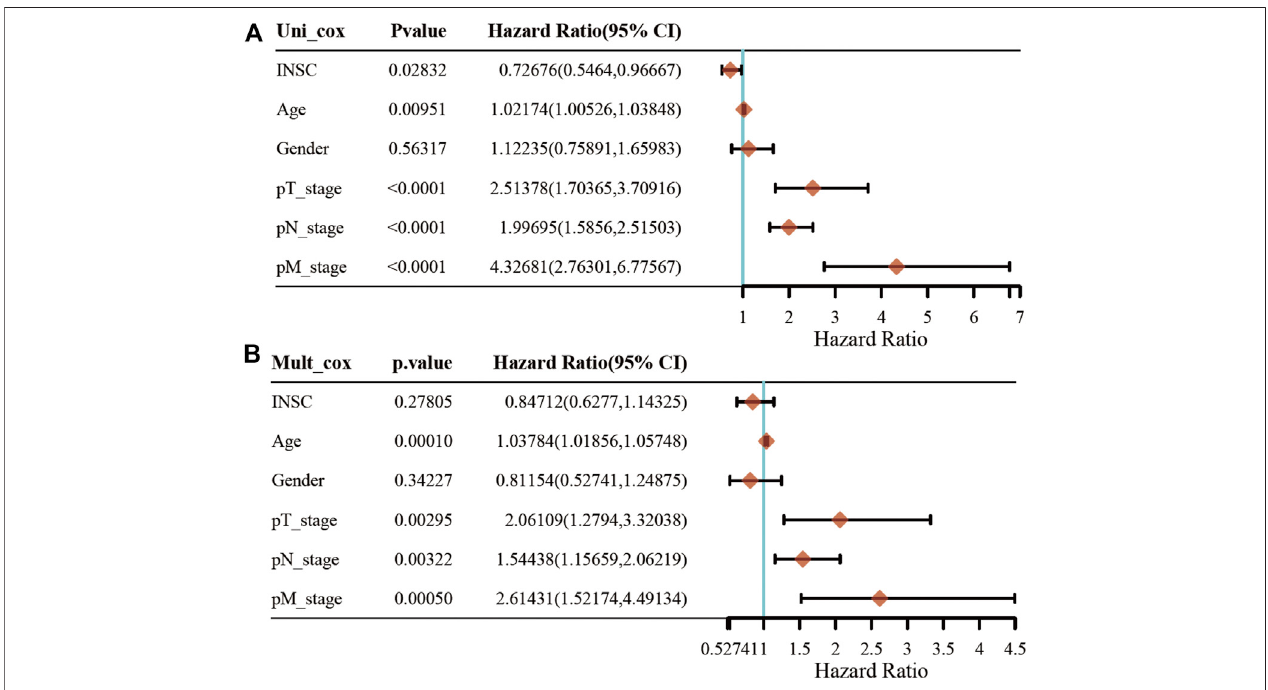
FIGURE 4 | Univariate and multivariate Cox regression of the INSC gene and other fi ve clinical characteristics. (A) The forest plot of univariate regression analysis. (B) The forest plot of multivariate regression